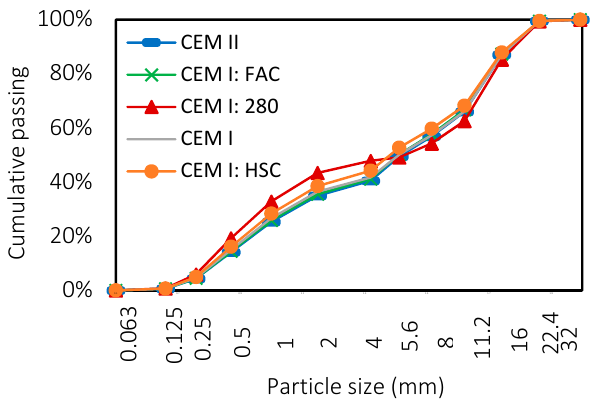
Figure 1. Grading of the mixes.